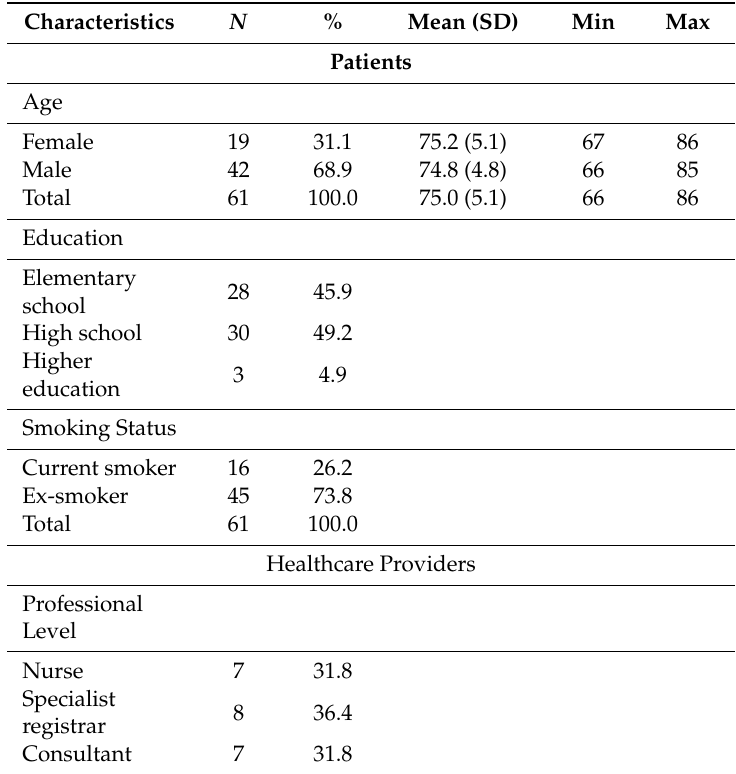
Table 1. Survey participants’ data.